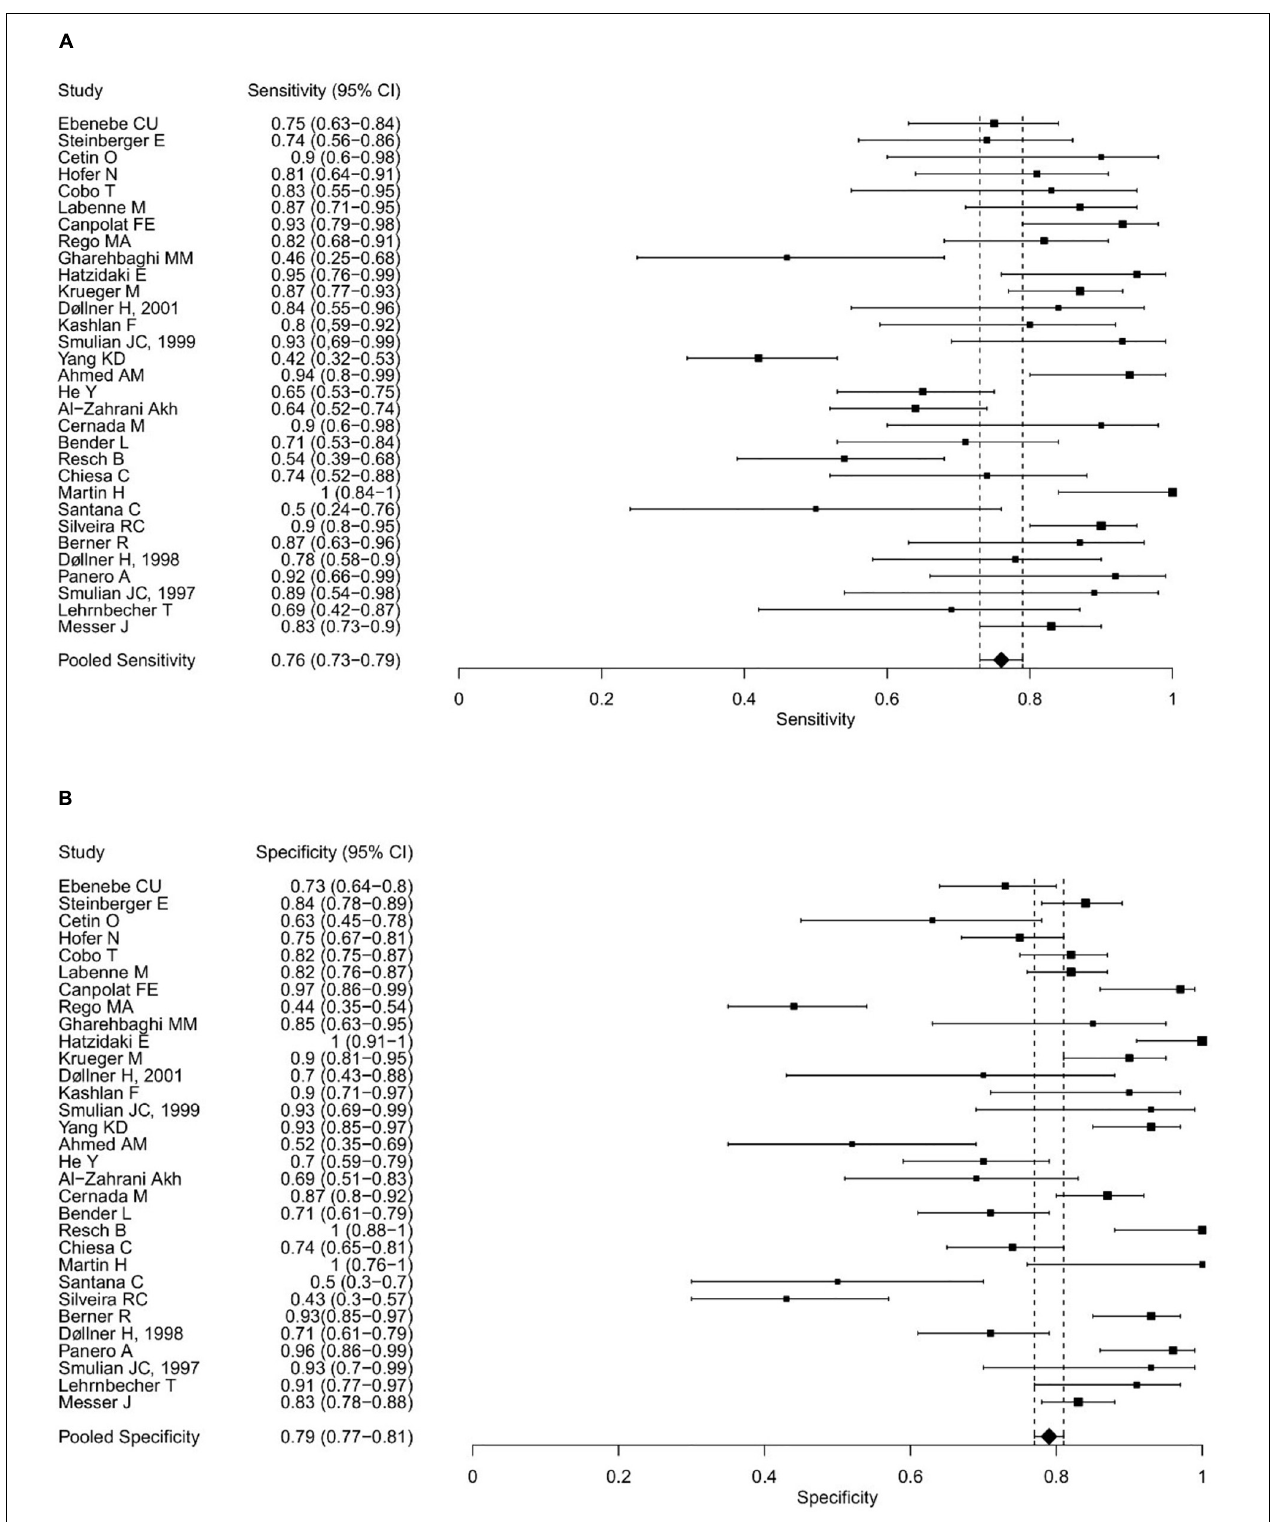
FIGURE 3 | Forest plots showing the individual and pooled sensitivities (A) and specificities (B) of IL-6 diagnostic accuracy studies for the diagnosis of EONS.